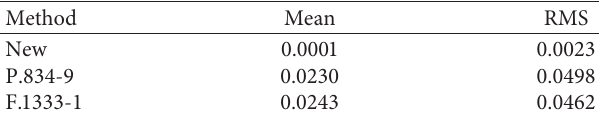
Table 3: Errors for an orbit of 100km when the apparent elevation angle is known (in degrees).